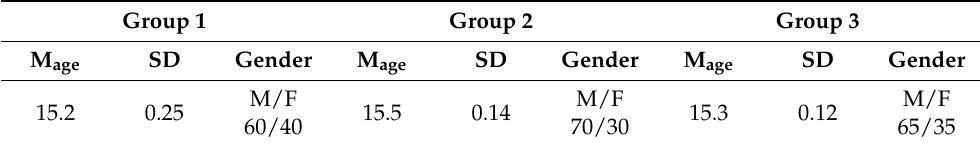
Table 1. Subdivision of the